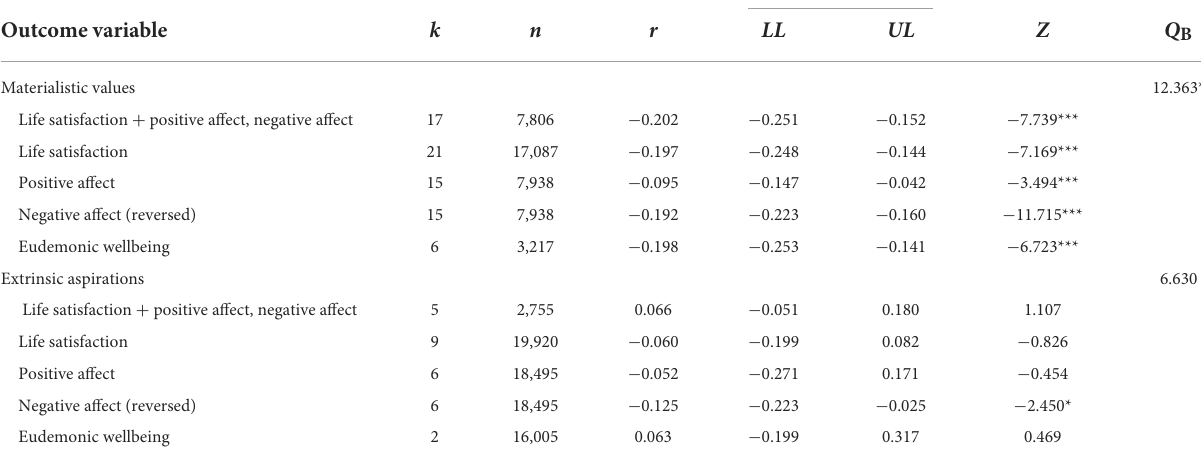
TABLE 4 Moderation by type of subjective wellbeing